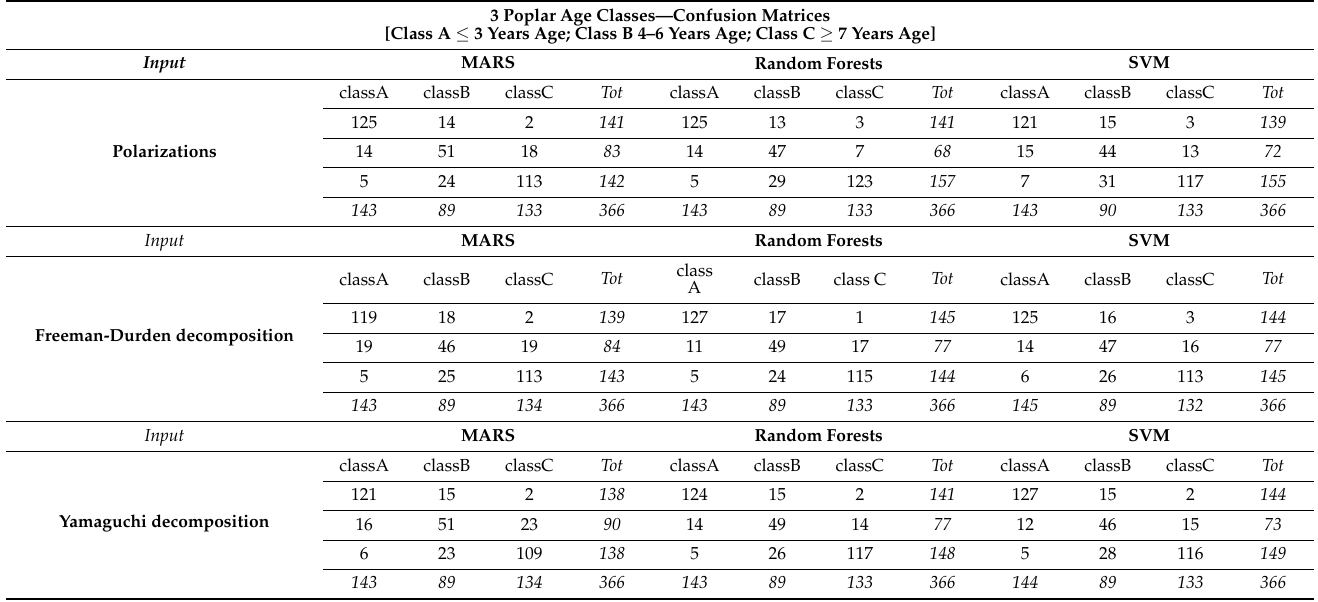
Table 3. Confusion matrices for the 3 age class classifications using different MARS, Random Forests, and SVM algorithms and all the available predictors, with a 10-fold cross validation